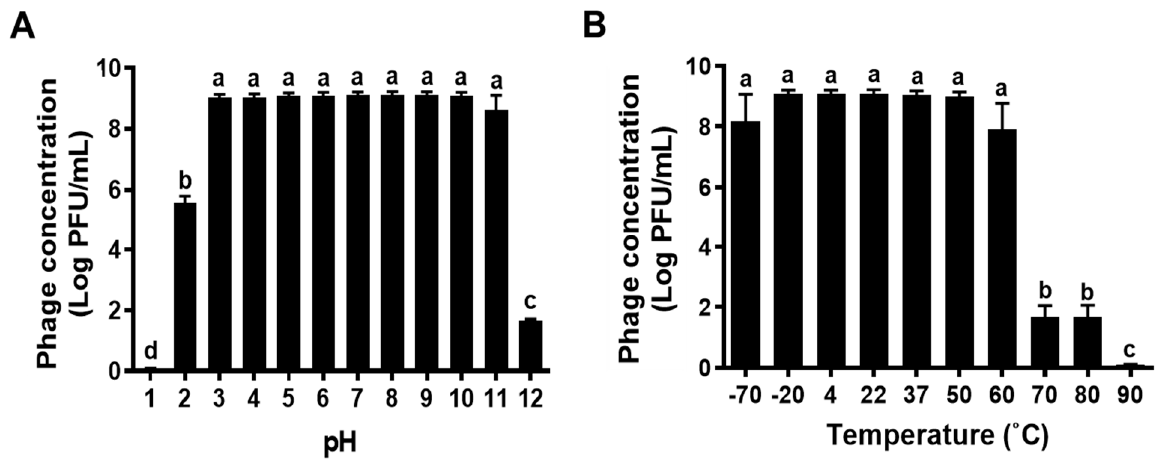
Figure 3. The stability of KFS-EC3 at various ( A ) pHs and ( B ) temperatures. Different letters (a–d) on the bars of either pH or temperature values indicate that the mean values differ significantly by one-way ANOVA test ( p < 0.05).